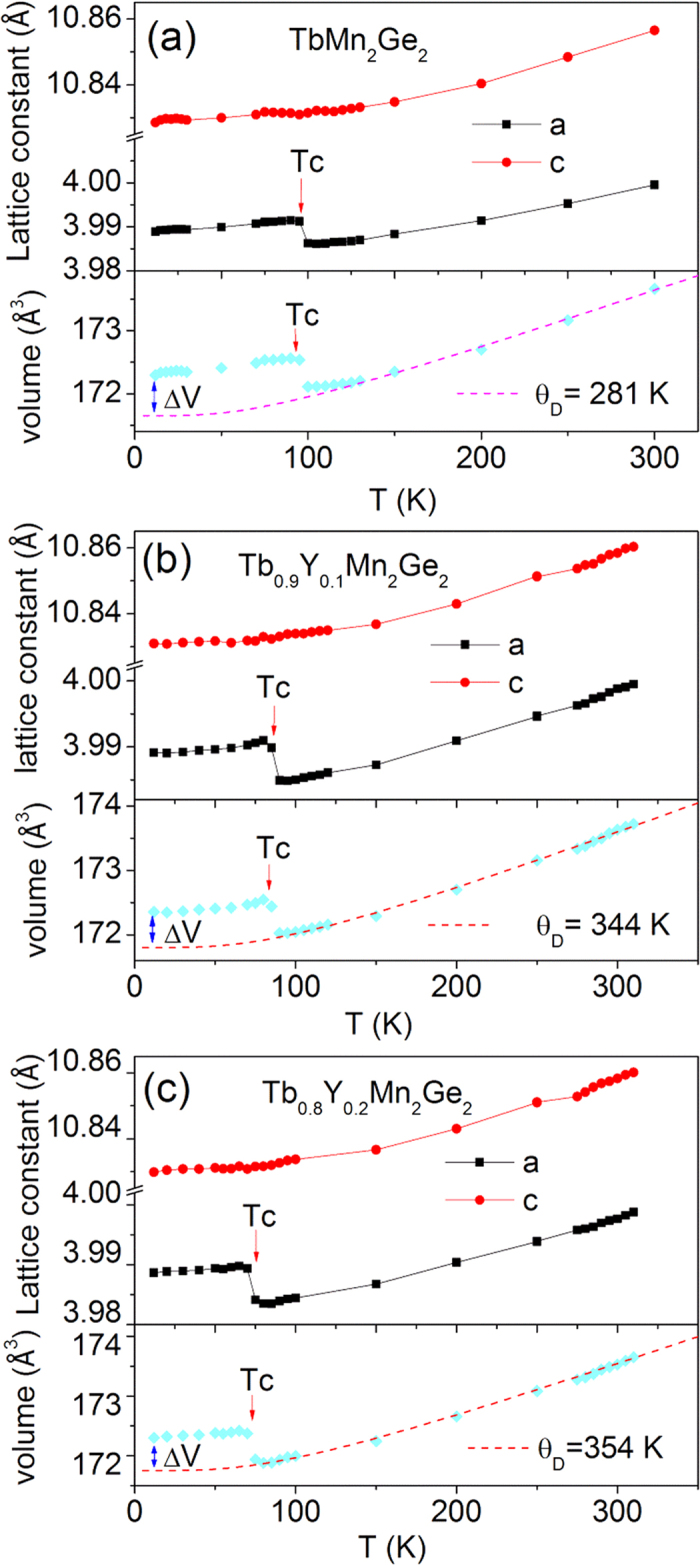
Temperature dependence of the lattice constants a, c and unit cell volume: (a) TbMn2Ge2, (b) Tb0.9Y0.1Mn2Ge2 and (c) Tb0.8Y0.2Mn2Ge2. The dashed lines show the phonon contribution to the lattice expansion as evaluated from the Gruneisen relation.